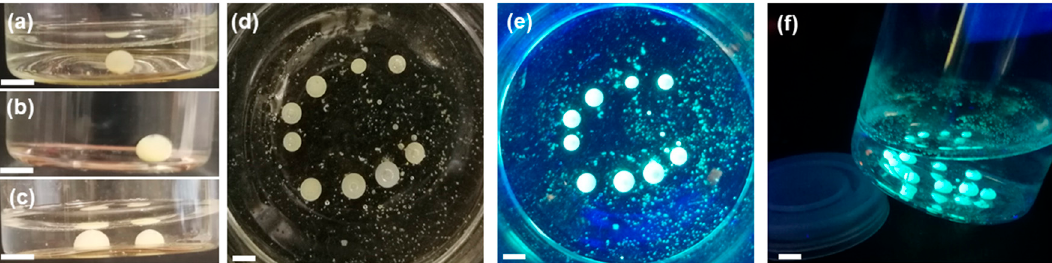
Figure 2. Digital images of CMp-vTA/chloroform (CN/TCM) droplet in aqueous PEI solution at ( a ) pH = 2; ( b ) pH = 7; ( c ) pH = 9; ( d ) macroscopic ‘c’-shaped organic droplets; ( e ) fluorescent image of ‘c’-shaped organic droplets ( f ) fluorescent image of tilted glass vial containing ‘c’-shaped organic droplets. Scale bars correspond to 1 cm.